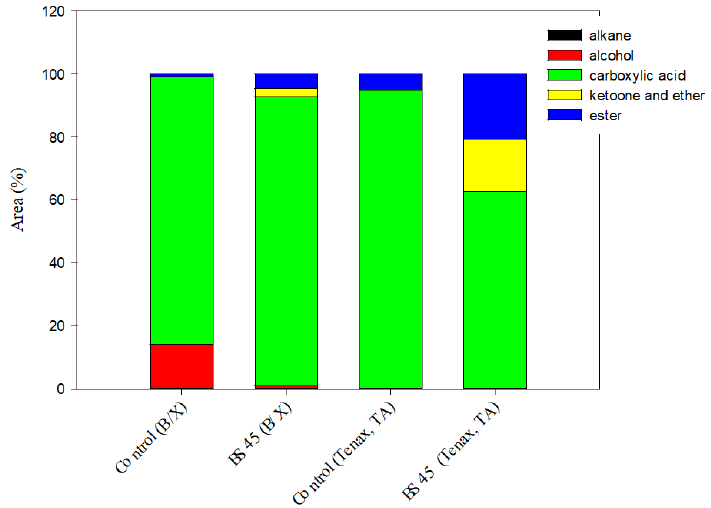
Figure 2. Volatile compound composition of control dough and black rice sourdough with added 45% black rice powder fermented for 36 h. B/X: volatile compounds were sampled with carbopack B/carbopack X adsorption tubes; TA: volatile compounds were sampled with tenax TA adsorption tubes.